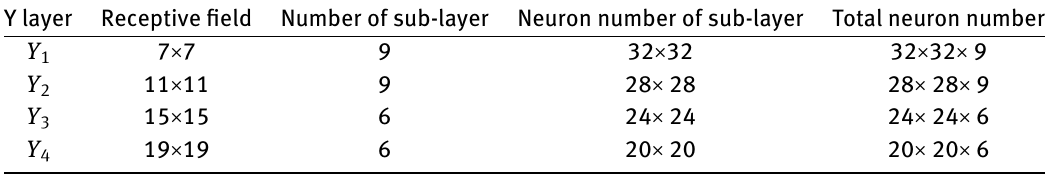
Table 1: Internal Parameters of Each Part in Y Layer Y